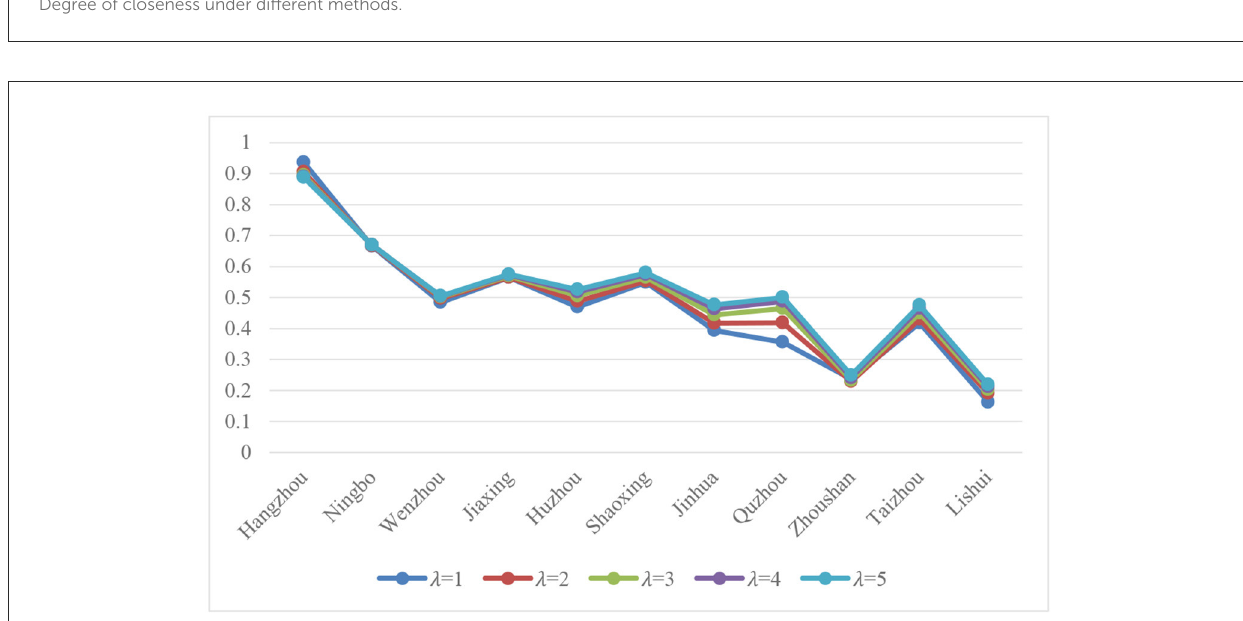
FIGURE3 Degree of closeness under different methods.